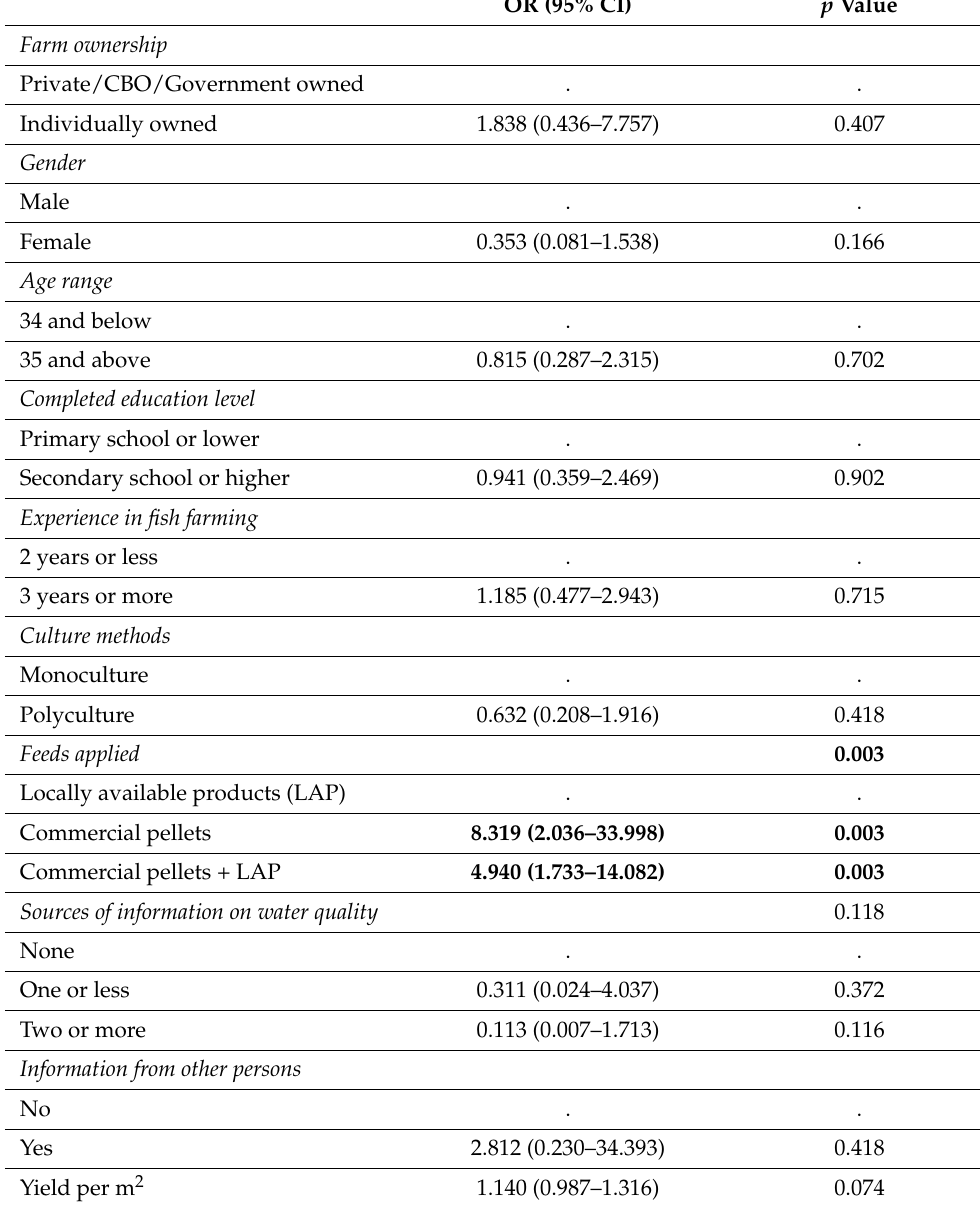
Table 6. Binary logistic regression analysis of factors associated with knowledge with regards to water quality management among fish farmers of the Rwenzori